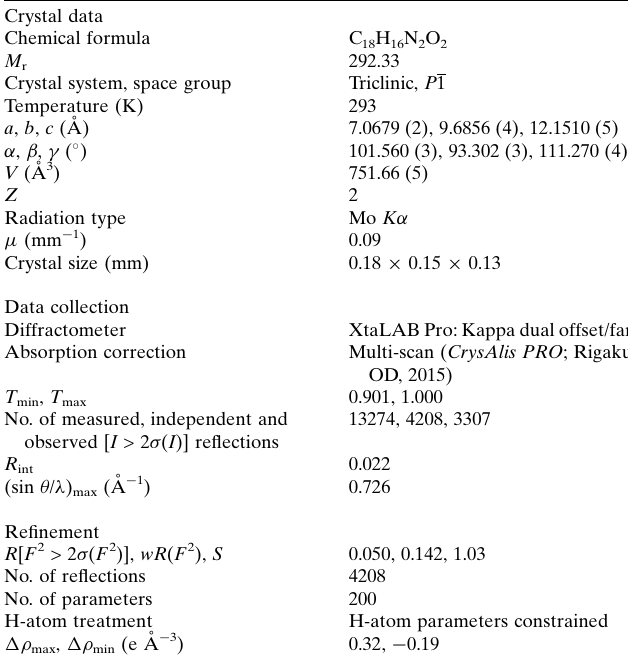
Table 2 Experimental details.